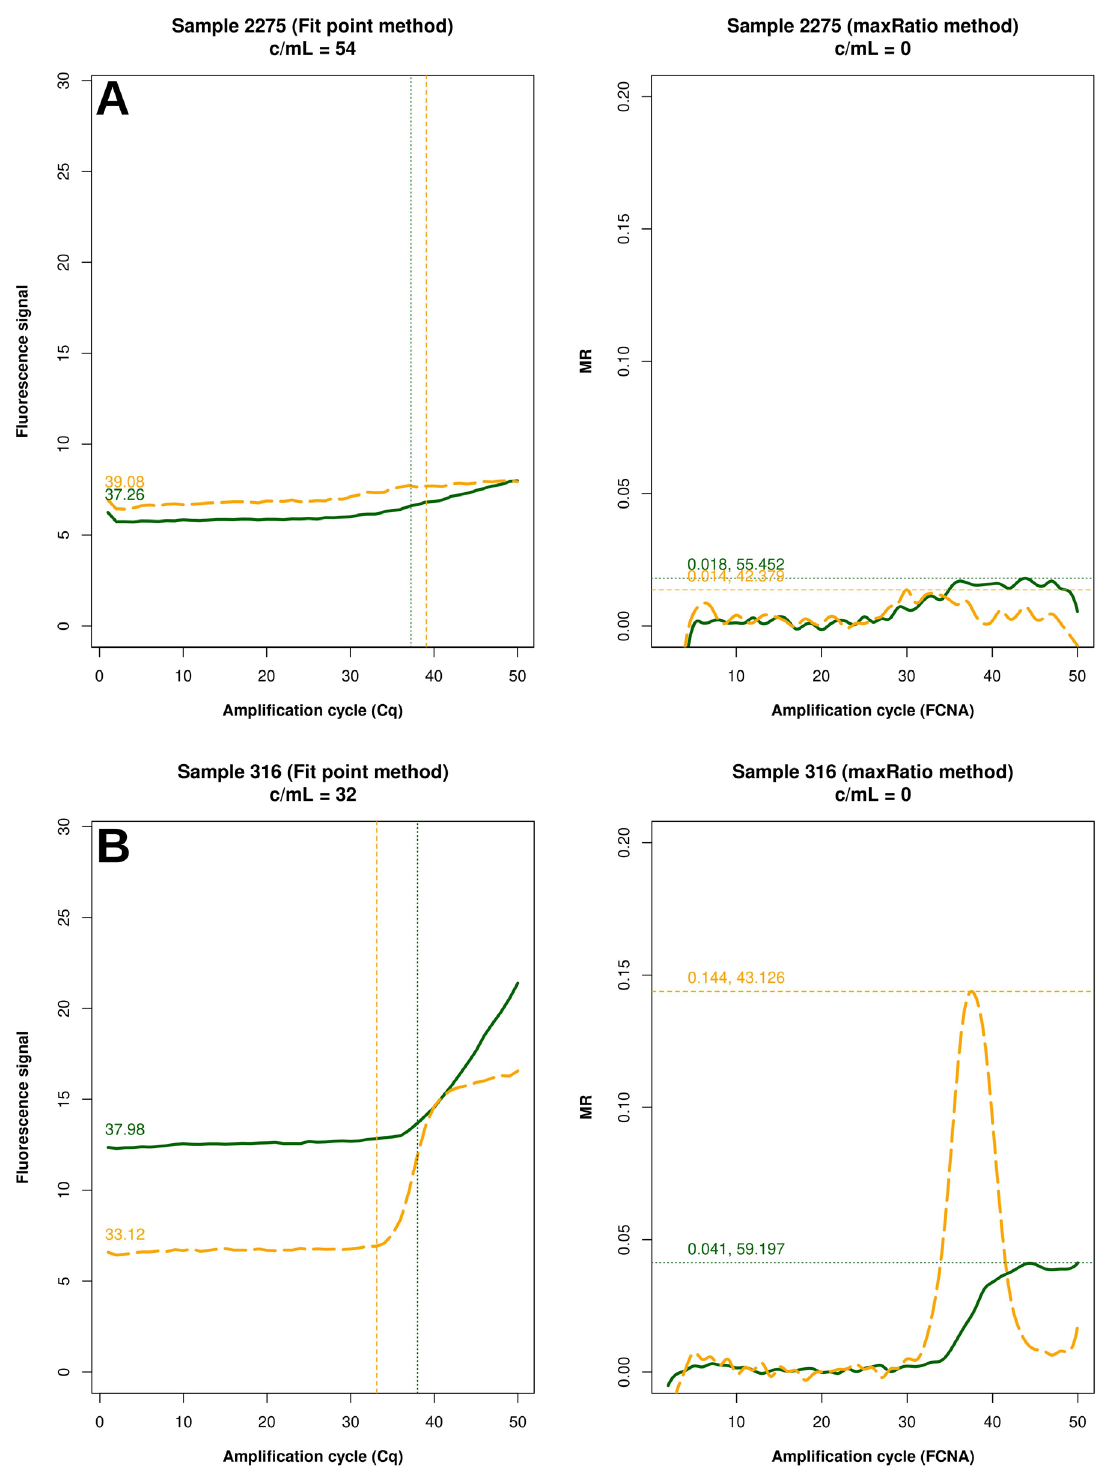
Figure 6. Samples not quantified only by maxRatio. Example of raw amplification profiles for the samples whose maxRatio did not provide a VL. The panels display the FP (left) the maxRatio (right) transforms of the amplification data. The solid line represents the HIV-1 template and the dashed line the IC template. ( A ) The majority of the samples had abnormal IC profiles that were overlooked by FP. ( B ) The minority of the samples showed proper amplification profiles, but the calculation provided fractional VLs that were rounded to